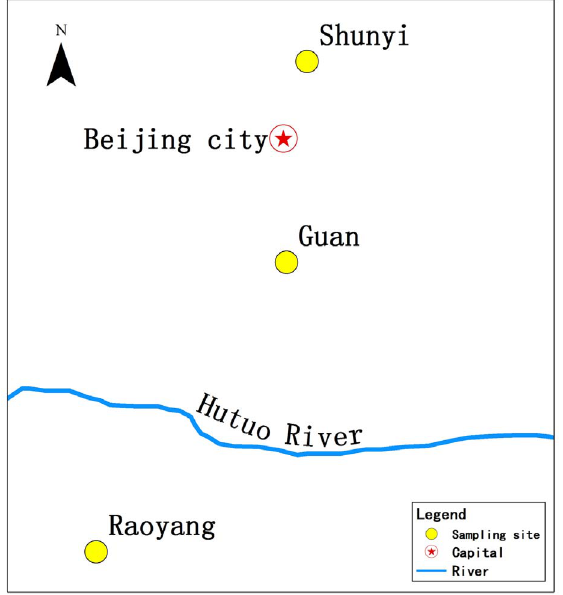
Figure 1. The sampling sites in the croplands of Raoyang, Guan and Shunyi Counties of the North China Plain and the potential barriers between the sampling sites.